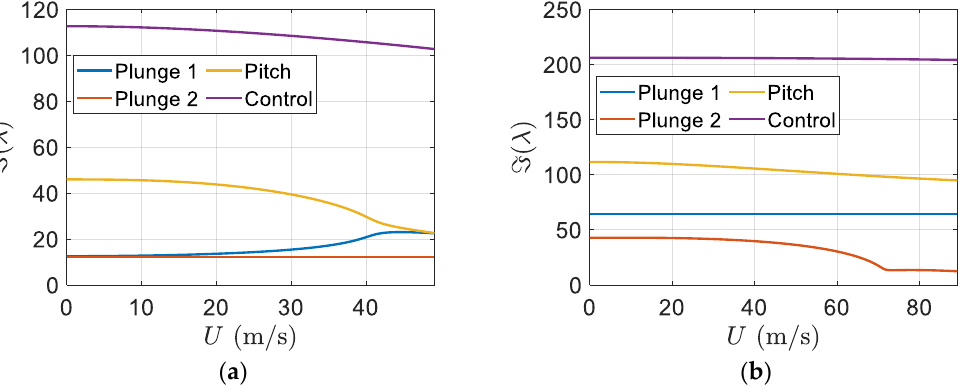
Figure 11. Eigenvalues real part versus airspeed: ( a ) regular blade; ( b ) smart blade. Figure 12 depicts the imaginary part of eigenvalues versus the freestream velocity. Figure 12b indicates the flutter speed of the smart blade can be effectively increased in comparison to that of the regular blade one.